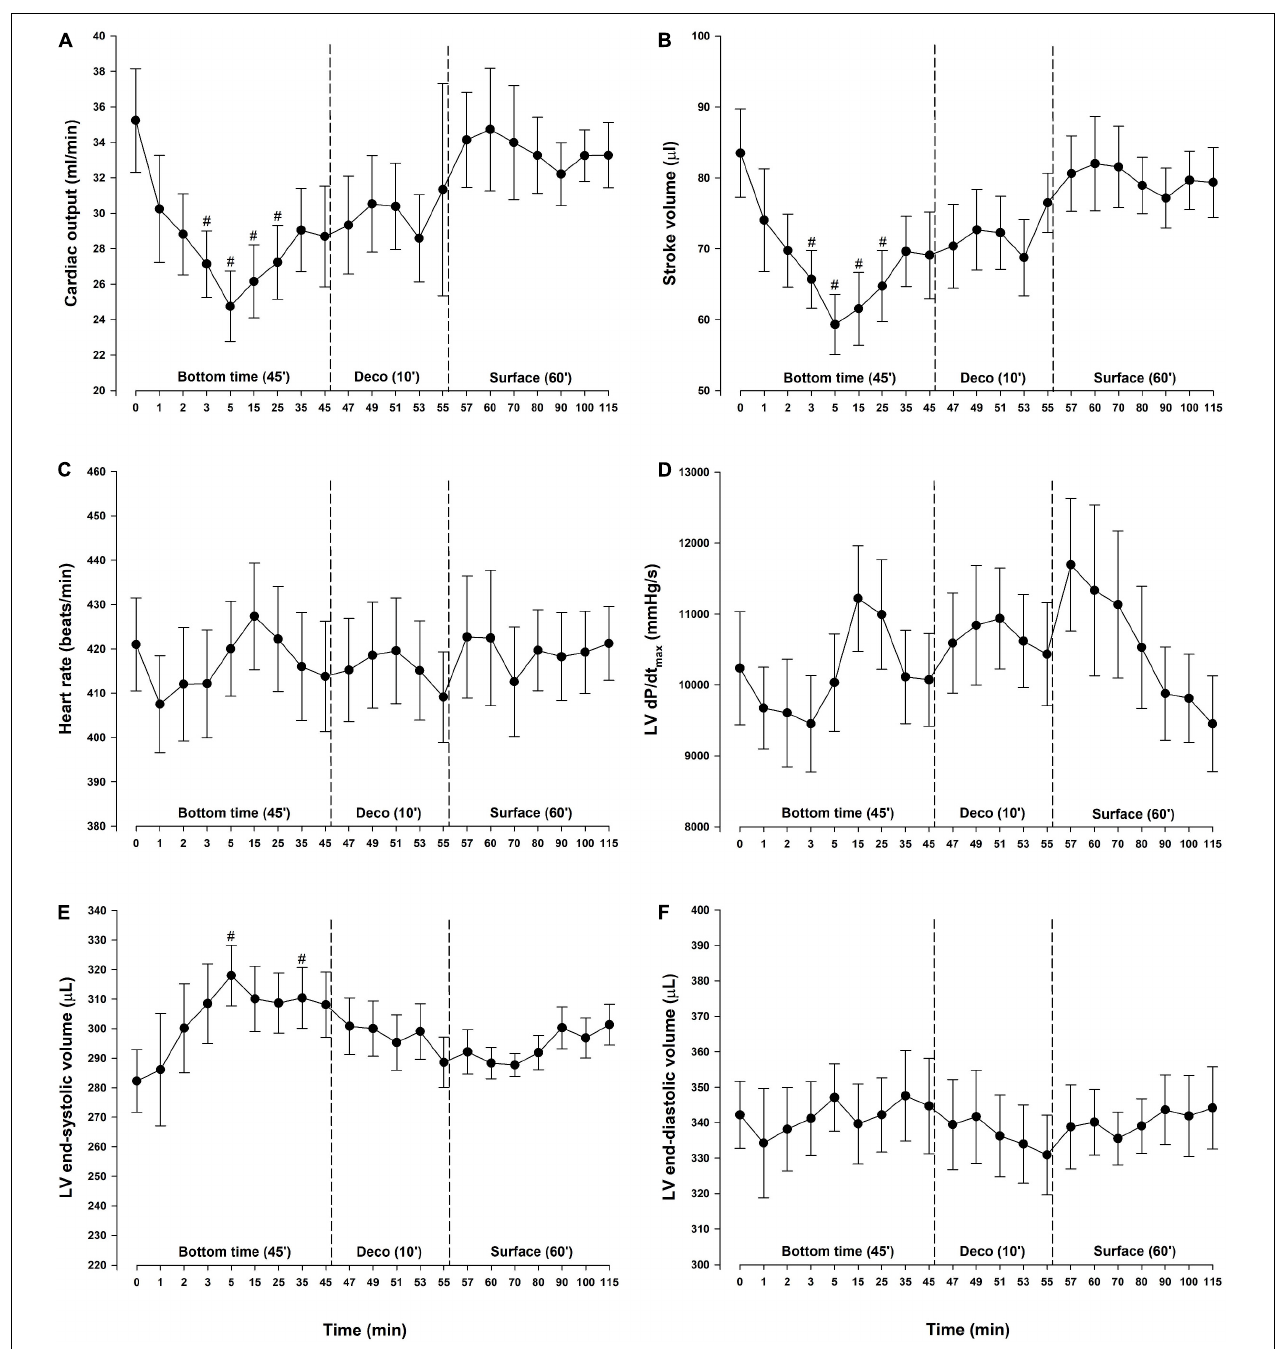
FIGURE 3 | Cardiac output and its determinants. (A) Cardiac output (CO), (B) stroke volume (SV), (C) heart rate (HR), (D) maximal slope of left ventricular systolic pressure increment (LV dP/dt max ), (E) left ventricular (LV) end-systolic volume and (F) left ventricular (LV) end-diastolic volume in rats exposed to simulated diving ( n = 9). Data were assessed using one-way repeated measures ANOVA for normal distributed variables and Friedman repeated measures ANOVA on ranks for non-normal distributed variables. Values are mean ± SEM. # p < 0.05 compared to intragroup baseline.